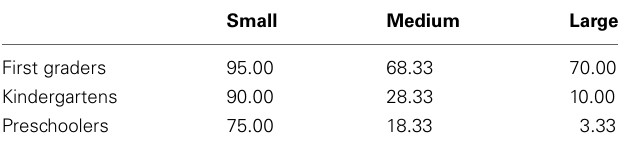
Table 2 | Percentages of correct responses in the counting task, as a function of school level and numerosities.